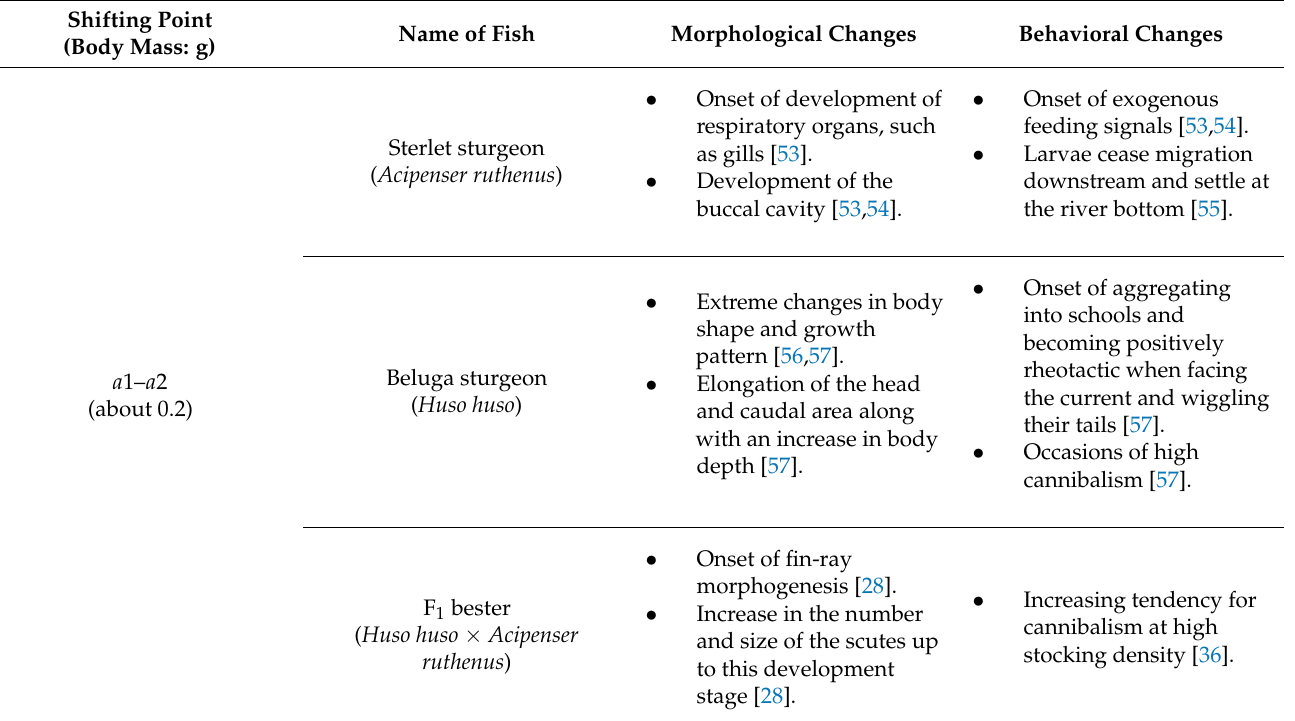
Table 3. Summary of the changes in morphology and behavior associated with a phase shift in the scaling constant a i during transitional